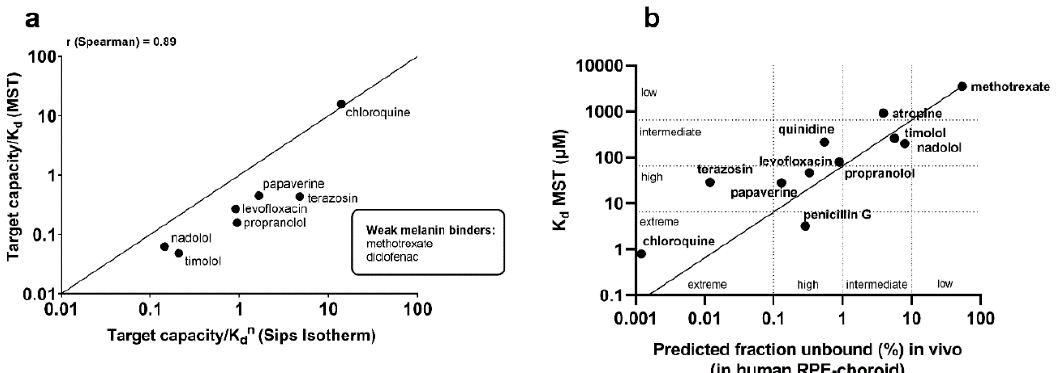
Figure 1. Melanin binding observed in MST experiments had good correlation between binding observed in traditional in vitro assays ( a ) and predicted in vivo binding ( b ). ( a ) Comparison of target capacity / K d values from microscale thermophoresis (MST) and target capacity / K dn from the traditional binding assay utilizing Sips isotherm resulted in a correlation of r = 0.89 (Spearman, p < 0.05; the solid line is the line of identity). ( b ) Linear regression (the solid line) between K d values obtained with MST and predicted in vivo melanin binding enables crude predictions of in vivo melanin binding with the obtained equation of K d (MST) = 65 * fraction unbound in vivo (%), the dotted lines indicate the classification limits into extreme (K d < 6.5 µ M), high (K d 6.5–65 µ M), intermediate (K d 65–650 µ M), and low (K d > 650 µ M) melanin binders ( y -axis, B). The K d limits were based on predicted fraction bound values in human RPE-choroid (fraction (%) bound of ligand; low ( > 10%), intermediate (1–10%), high (0.1–1%), and extreme ( < 0.1%). Table 3. Limits for the binding classes based on the linear correlation seen in Figure 1b. Class